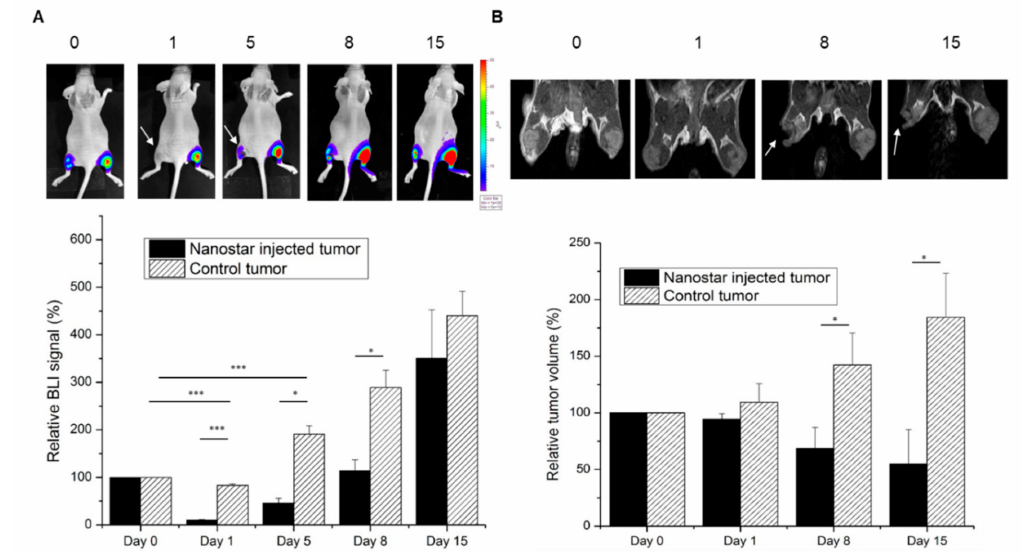
Figure 7. ( A ) In vivo bioluminescence imaging (BLI) before (day 0) and after PTT (days 1, 5, 8) illustrated in a color-coded intensity map. A quantification of the BLI signal intensity relative to day 0 (set to 100% for each mouse) is plotted for both nanostar-injected and control (PBS-injected) tumors (RT); ( B ) MR images of the tumor-bearing hind limbs taken at corresponding time points (days) after nanostar- or PBS-injection. The white arrow indicates the tumor damage (hypointense area) after PTT at the nanostar-injected tumor. The relative mass volumes were quantified relative to day 0 (set at 100% per mice). For both BLI and magnetic resonance imaging (MRI) graphs, the error bars represent SD; n = 6;